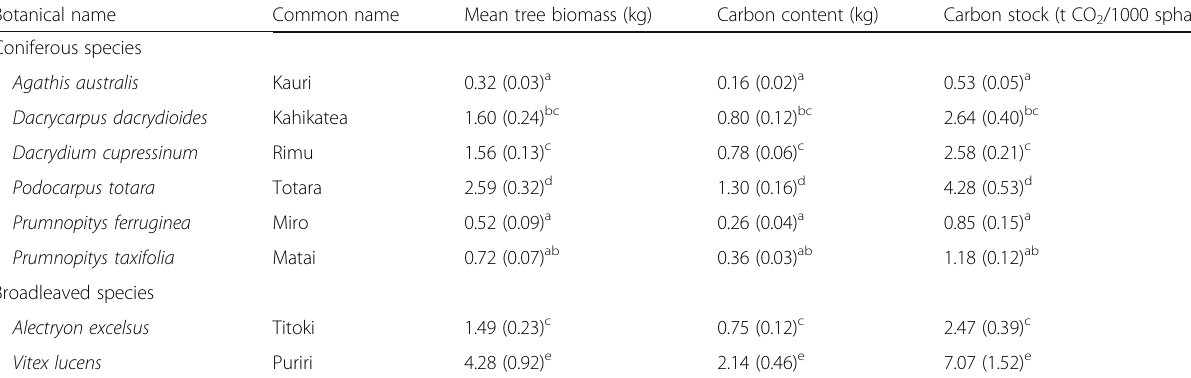
Table 4 Mean tree biomass (dry weight), carbon content (kg) and carbon stock (t CO 2 /1000 stems per hectare) for 5-year-old